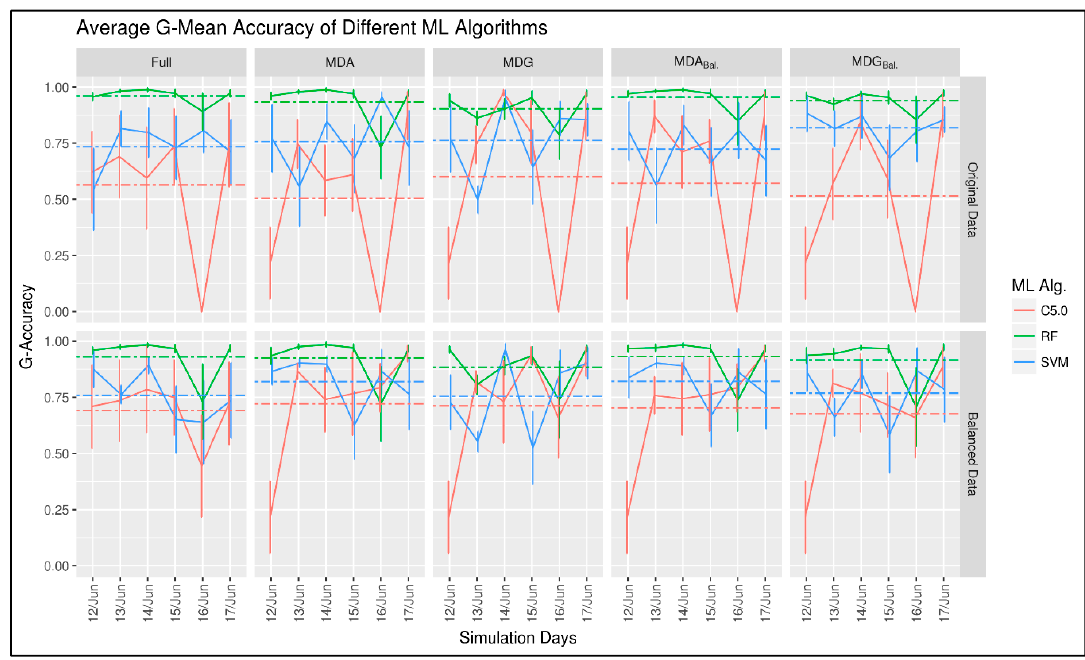
Figure 11. Comparison plot of the average accuracy of every C5.0, RF and SVM model for every feature set and data balance combination.